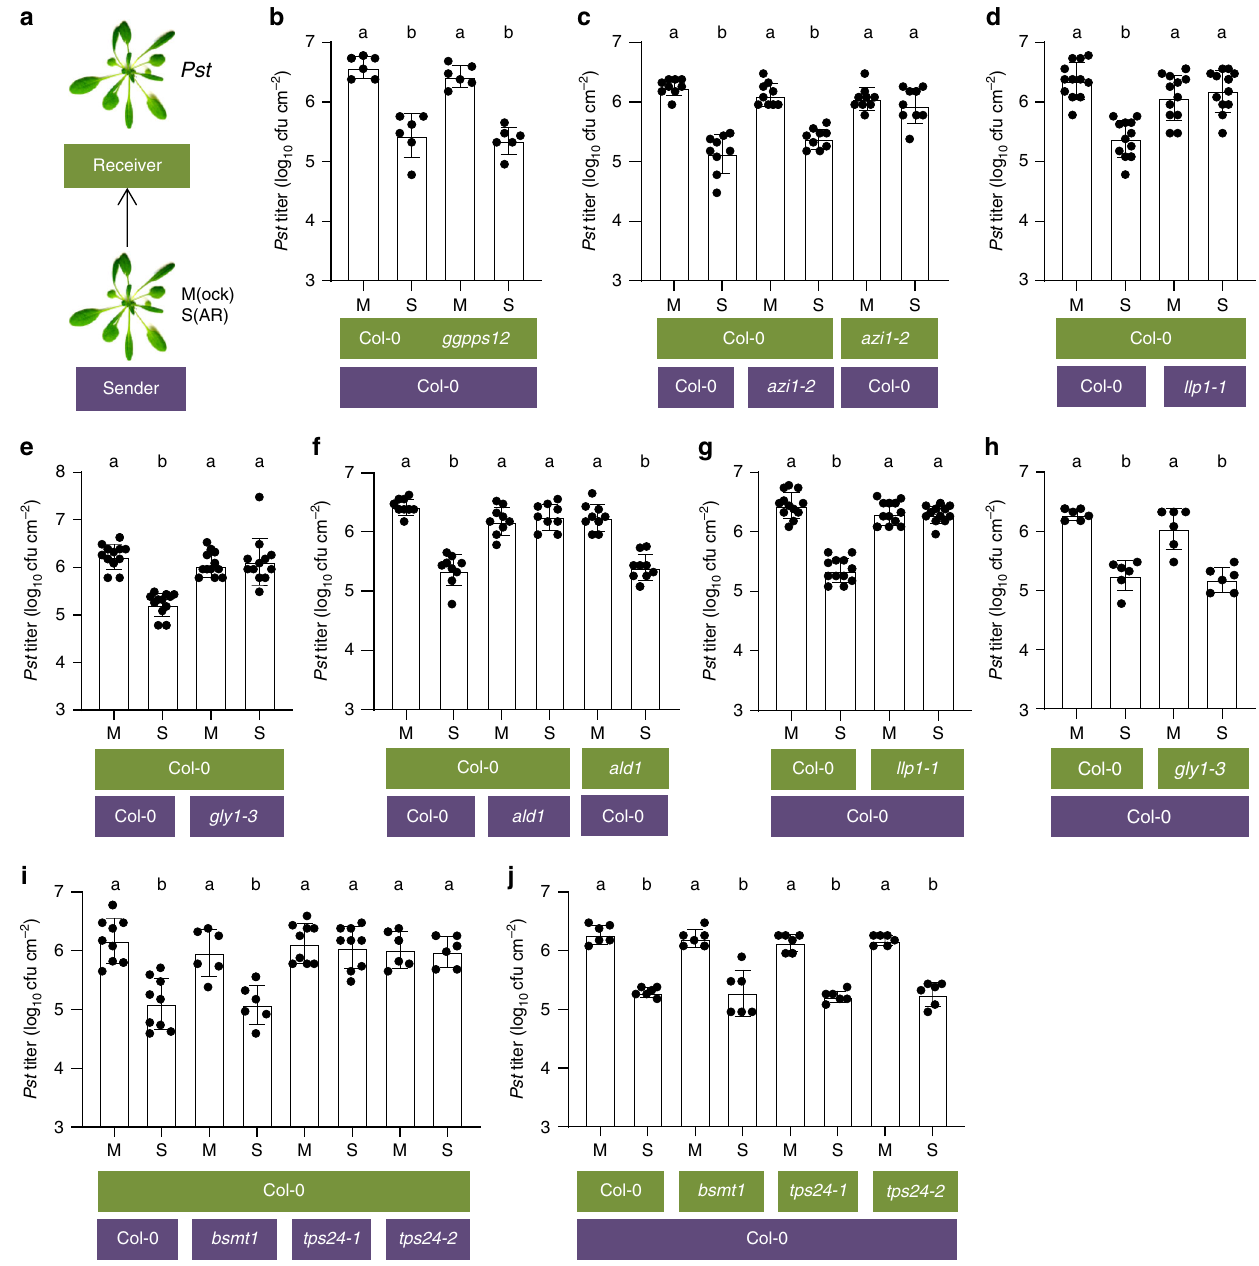
Fig. 5 Plant-to-plant (PTP) propagation of innate immunity depends on LLP1, G3P, Pip, and TERPENE SYNTHASE 24 ( TPS24 ). a PTP experimental setup. Senders were either inoculated with Pst/AvrRpm1 (SAR-induced; S) or mock-treated (M), and incubated with naive receivers in gas-tight containers. The receiver plants were subsequently released from the containers and inoculated with Pst . b – j In planta Pst titers at 4 dpi of the receiver plants. The plant genotypes are indicated below the panels (senders in purple and receivers in green) and include bsmt1 with reduced MeSA emissions and tps24 with compromised monoterpene emissions. The treatments of the senders (M or S) are indicated below the bars. Dots indicate individual results from two ( b , h ; bsmt1 in i , j ), three ( c , f , i remaining genotypes), or more ( d , e , g ) biologically independent experiments, including three replicates each. Bars represent the average of the indicated results ± standard deviation. Different letters above bars indicate signi fi cant differences, one-way ANOVA, P <